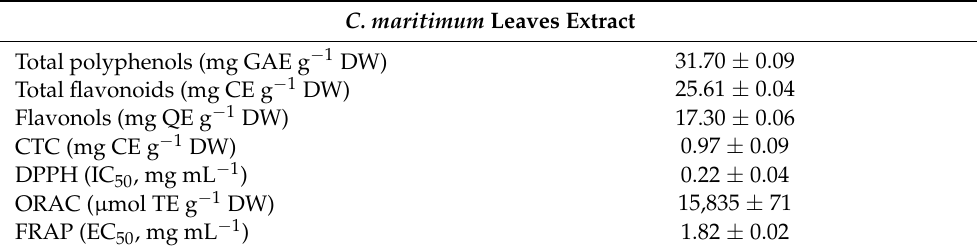
Table 1. Content of phenolic classes and in vitro antioxidant activities of hydro-ethanolic extract of C. maritimum leaves.